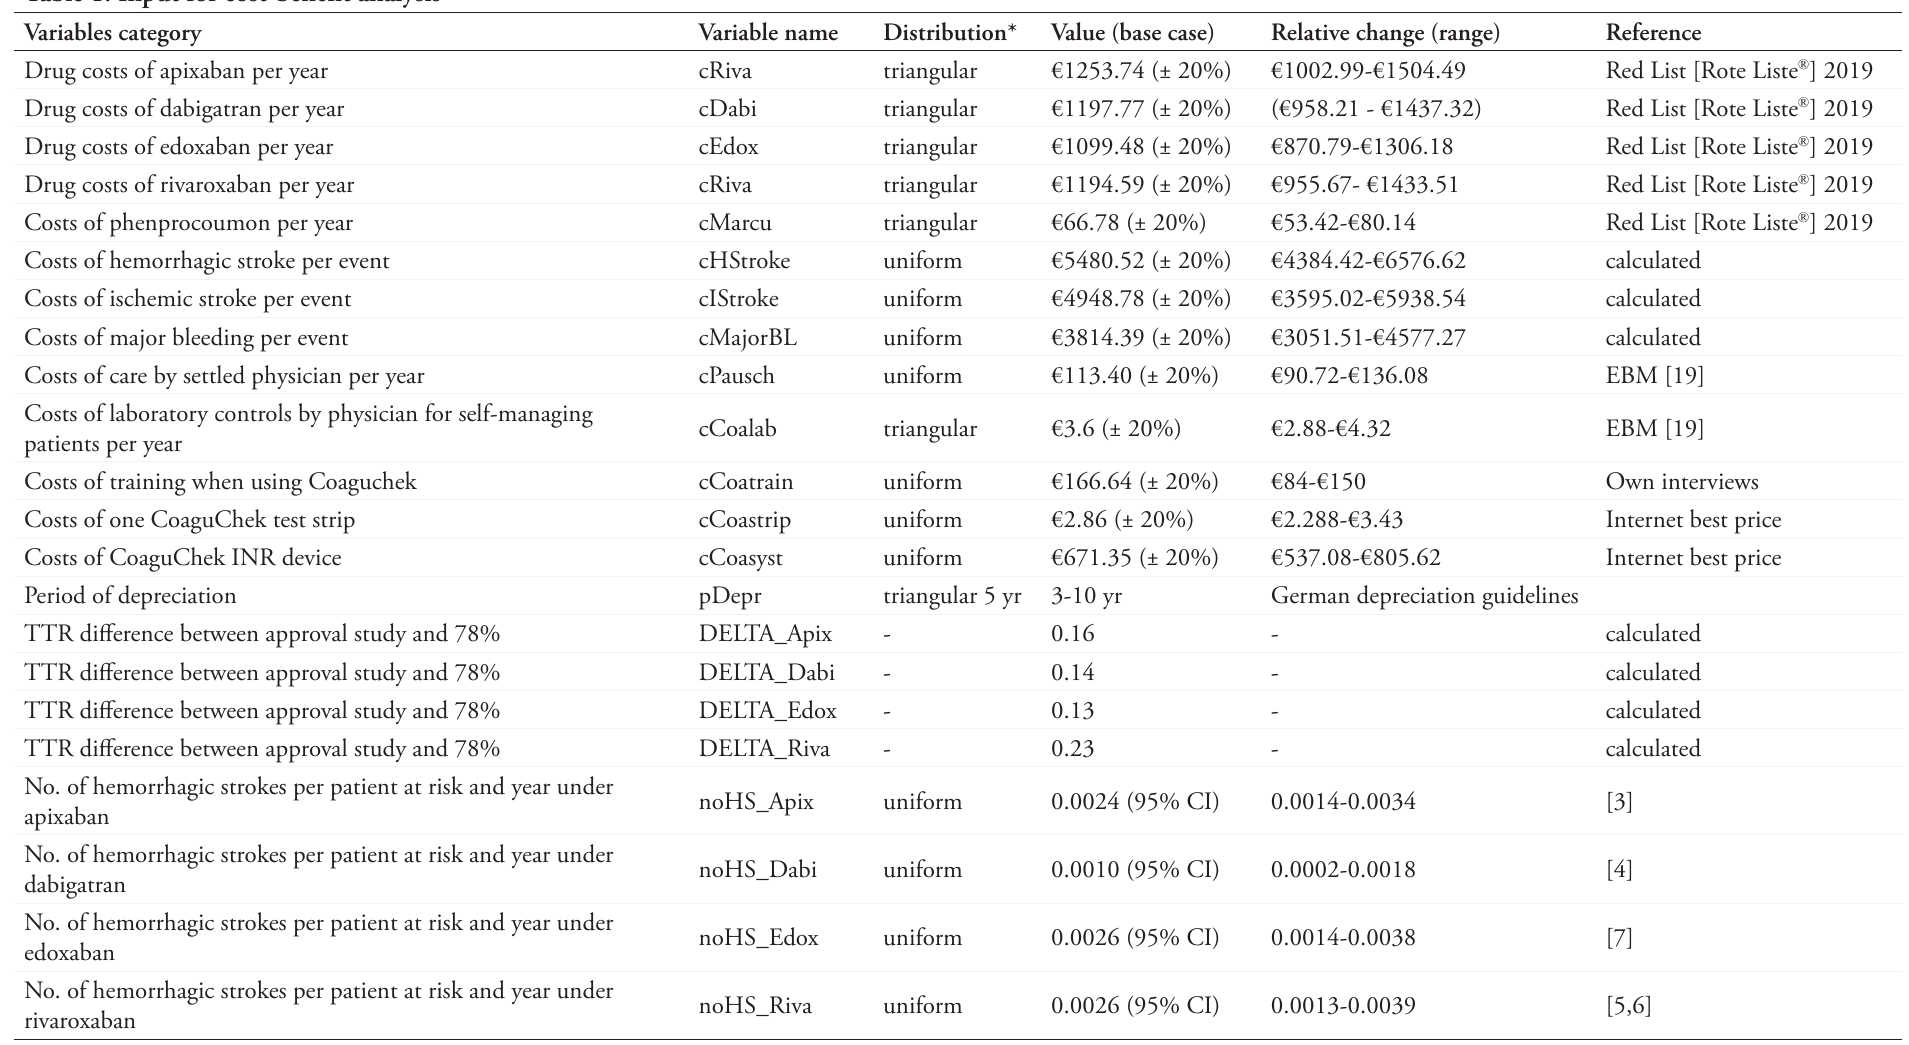
Table 1: Input for cost-benefit